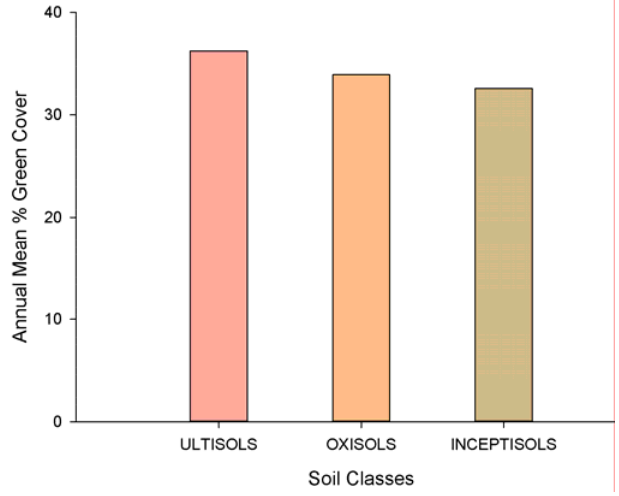
Figure 9. Average distribution of annual mean greenness values (2009–2010 hydrological cycle) according to the major Cerrado soil